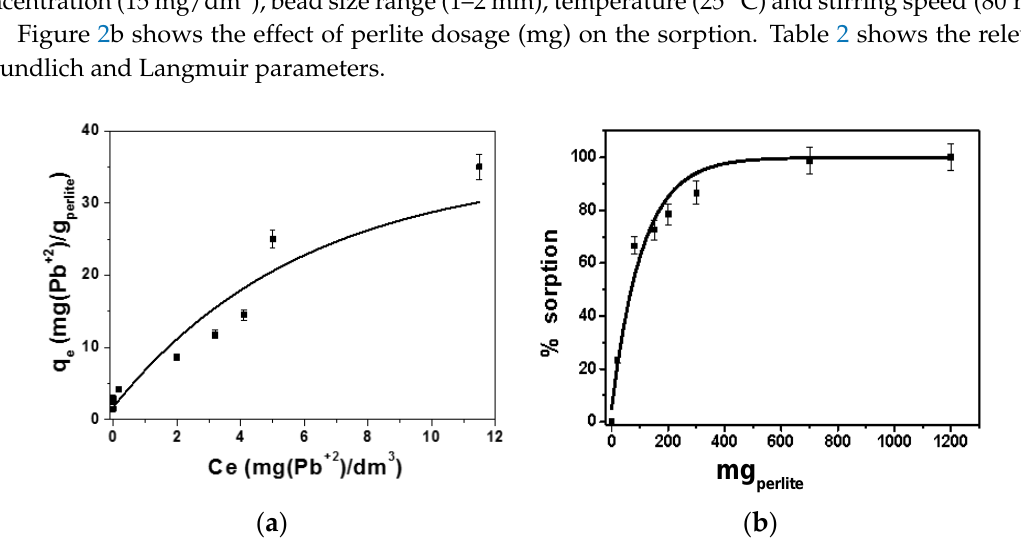
Figure 2. ( a ) Single batch test in de-mineralized water for lead ion retention on perlite (1–2 mm bead size, 80 rpm, 15 mg(Pb +2 )/dm 3 , 298 K); ( b ) effect of perlite dosage on the sorption. Table 2. Freundlich ( K f , 1/ n ) and Langmuir parameters ( q max , b ) for lead ion retention in single and ternary solution batch